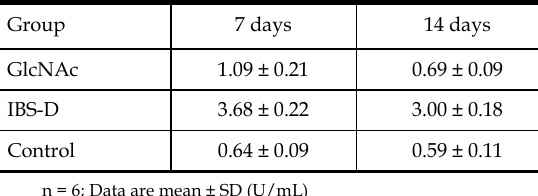
Table I: Serum D-lactic acid level after GlcNAc treatment Group